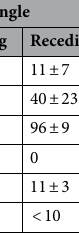
Table 1. Mean water contact angle measurements of test solids. The figure after ± sign is the 95% confidence interval. The contact angle was measured 10 s after the droplet was placed on the solid.